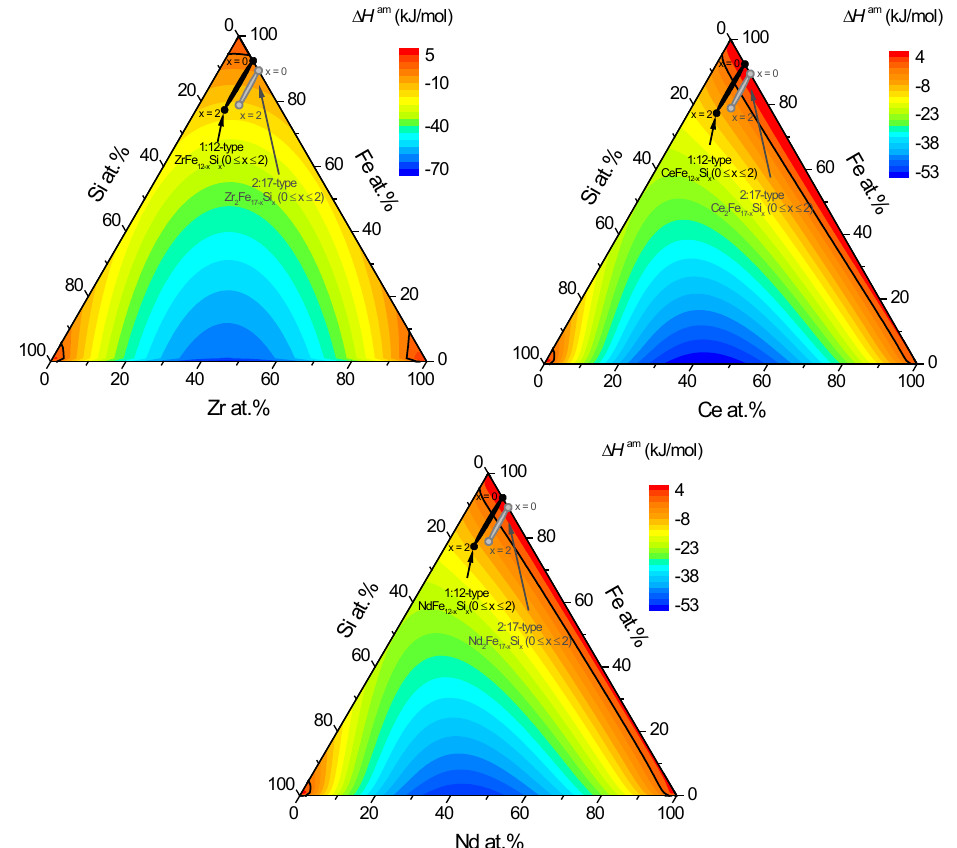
Figure 1. Compositional dependences of formation enthalpies of amorphous phase ∆ H am of ternary (Zr, Ce, Nd)-Fe-Si systems. Key composition regions are marked in grey (2:17-type phases) and black (1:12 type phases). Black solid lines are ∆ H = 0 indicators.